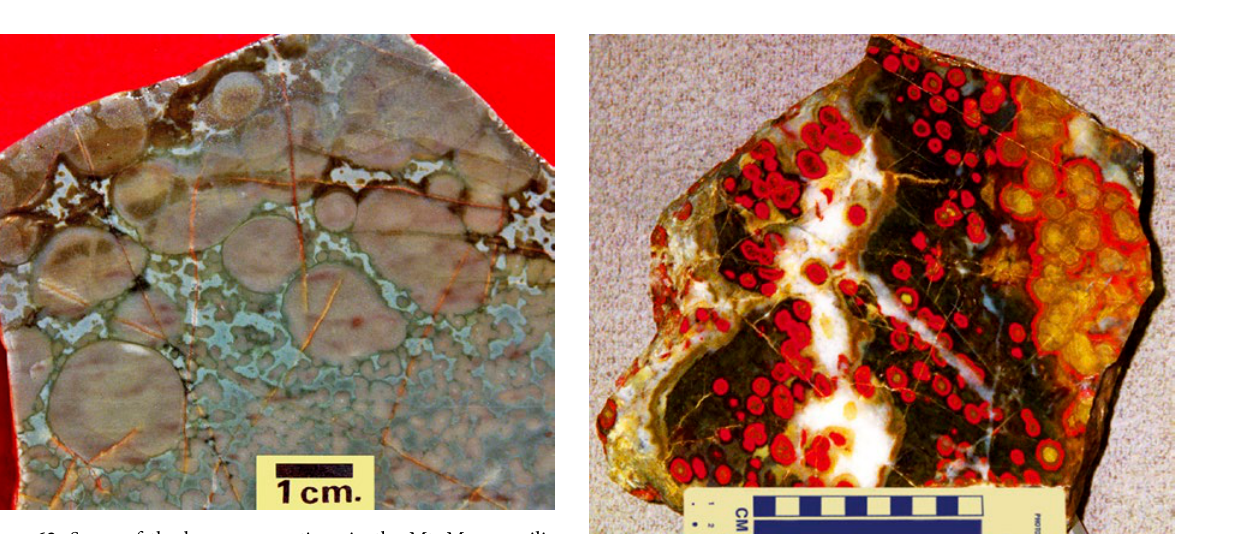
Figure 62. Some of the larger concretions in the Mt. Morgan sili- ceous 'elvan' grow over and incorporate smaller ones. Where the concretion has essentially the same composition as the less dense gel medium in which it is developing, the growth of the 'close- packed' nodule is often as much by infill and incorporation of the host silica gel matrix rather as by its displacement (like bedding preserved through concretions in sediments). Syneresis exudes impurities to the rims.